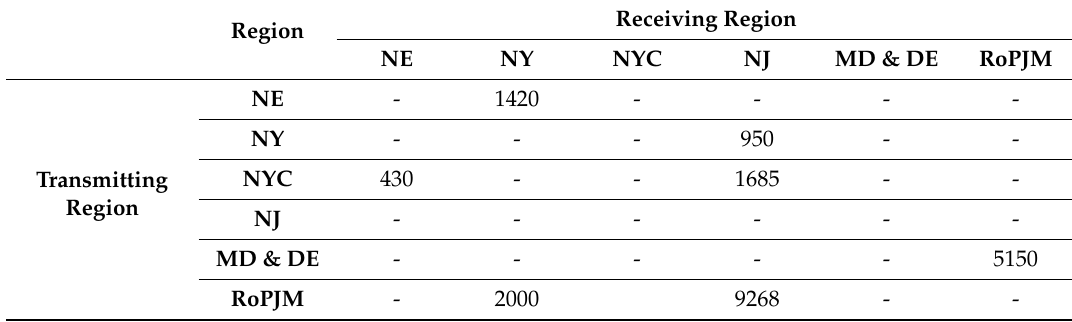
Table A2. Transmission Limits by Region (in MWh) (Cambridge Energy Solutions, 2011).